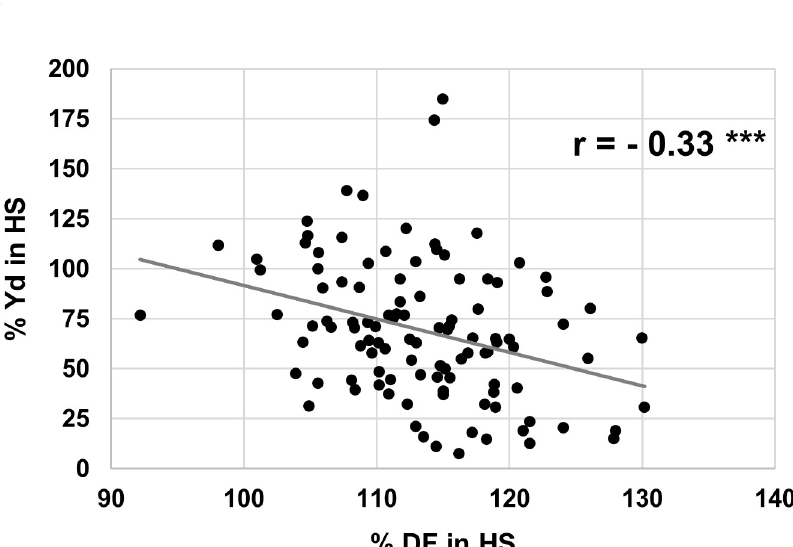
Fig 6. Phenotypic correlation of % yield retention and flowering time under heat stress (in % compared to non- stress). r represents Pearson’s correlation.